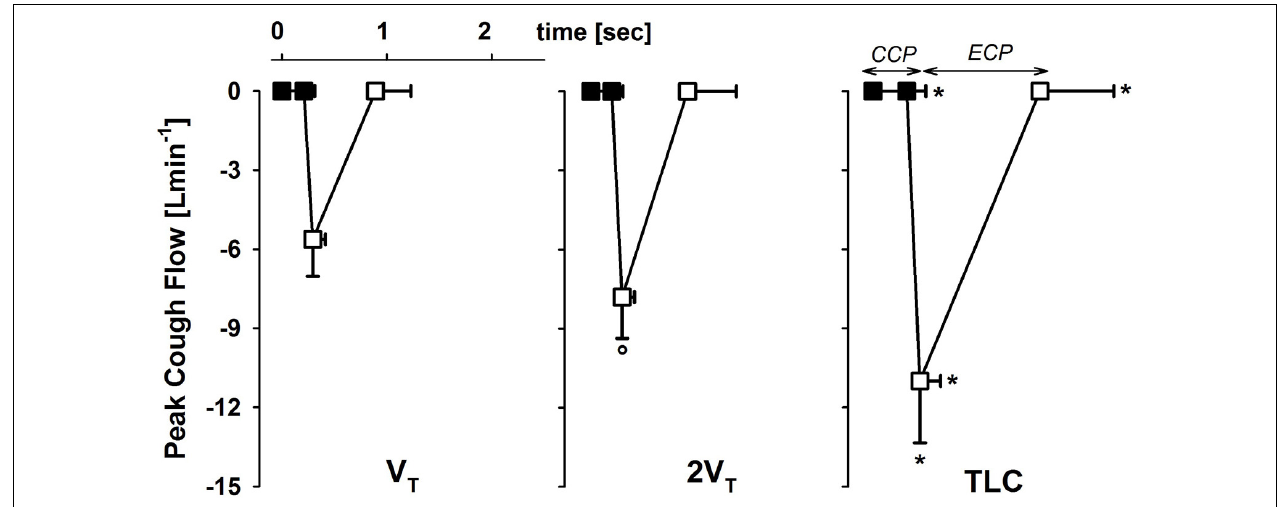
FIGURE 2 | Average values ± standard deviation of peak cough flow at each operating lung volume: one tidal volume (V T ) above functional residual capacity, left panel), total lung capacity (TLC, right panel), and an intermediate volume (2V T , middle panel). The x-axis displays the average values ± standard deviation of the duration of the compressive (CCP, close symbols) and the expulsive (ECP, open symbol) cough phases. ∗ p < 0.05 vs. both V T and 2V T ; ◦ p < 0.05 vs. V T